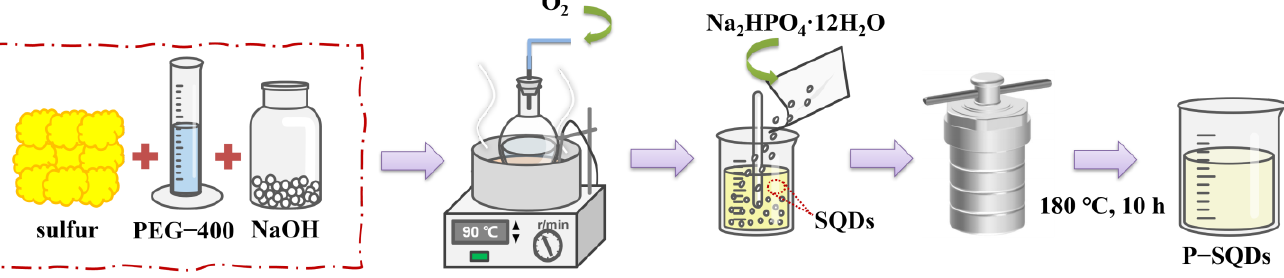
Figure 9. Preparation process scheme of P-SQDs/g-C 3 N 4 .